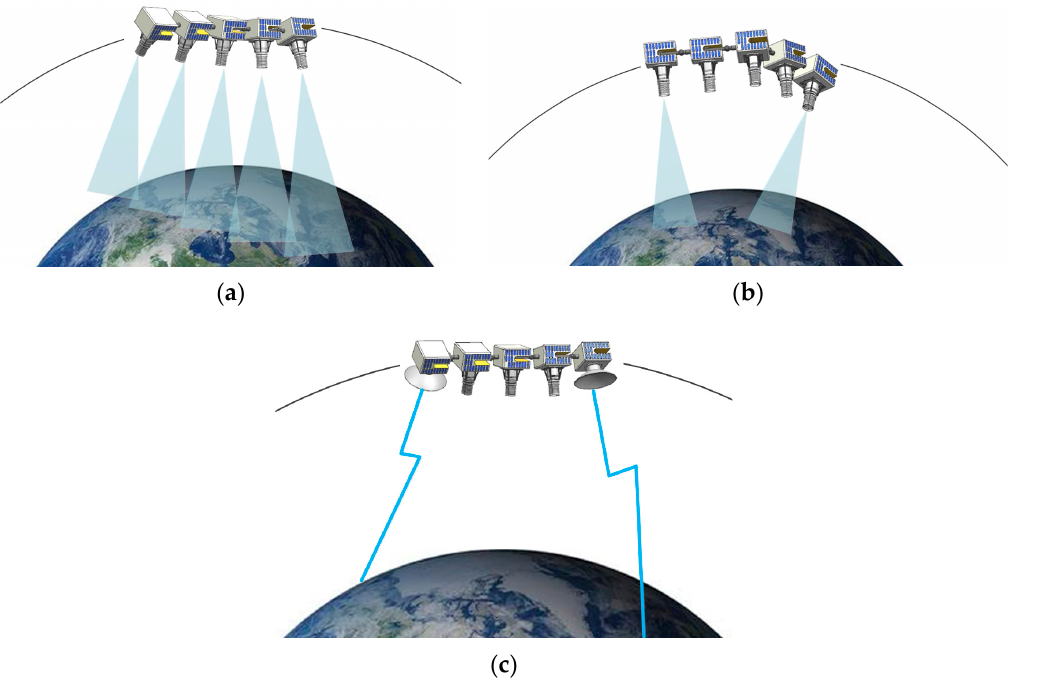
Figure 2. Application scenarios for SMSRS: ( a ) SMSRS carries multiple optical cameras and expands the imaging area by stitching together fields of view. ( b ) SMSRS reconnaissance of multiple targets by multiple optical cameras. ( c ) SMSRS carries multiple communication payloads to achieve multi-area communication to the earth.